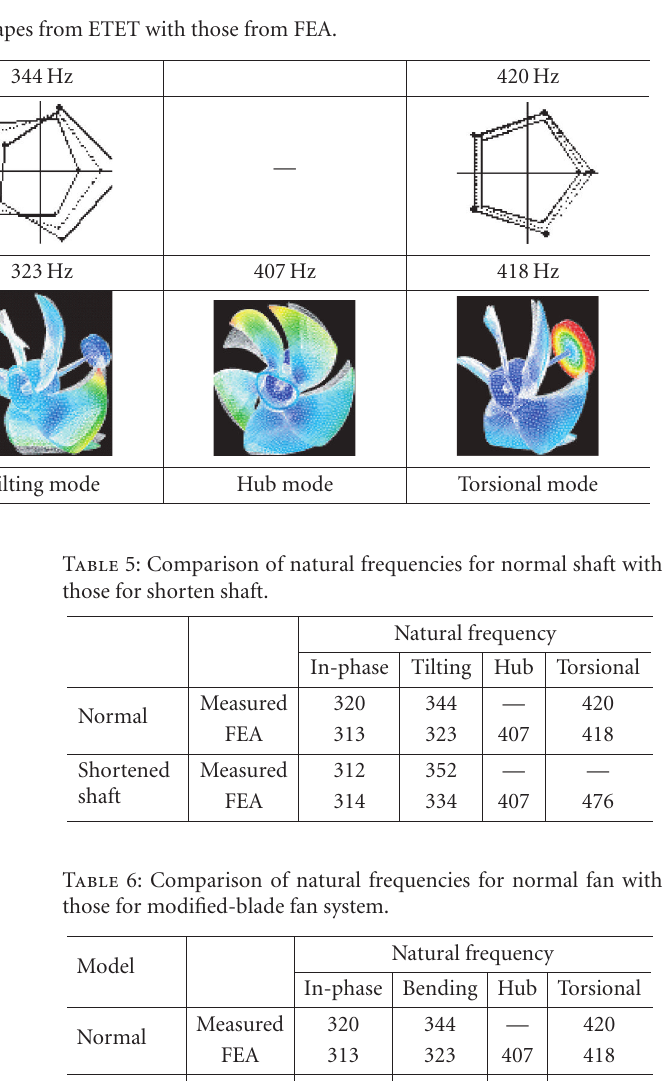
Figure 8: Noise level of normal shaft and shortened shaft.